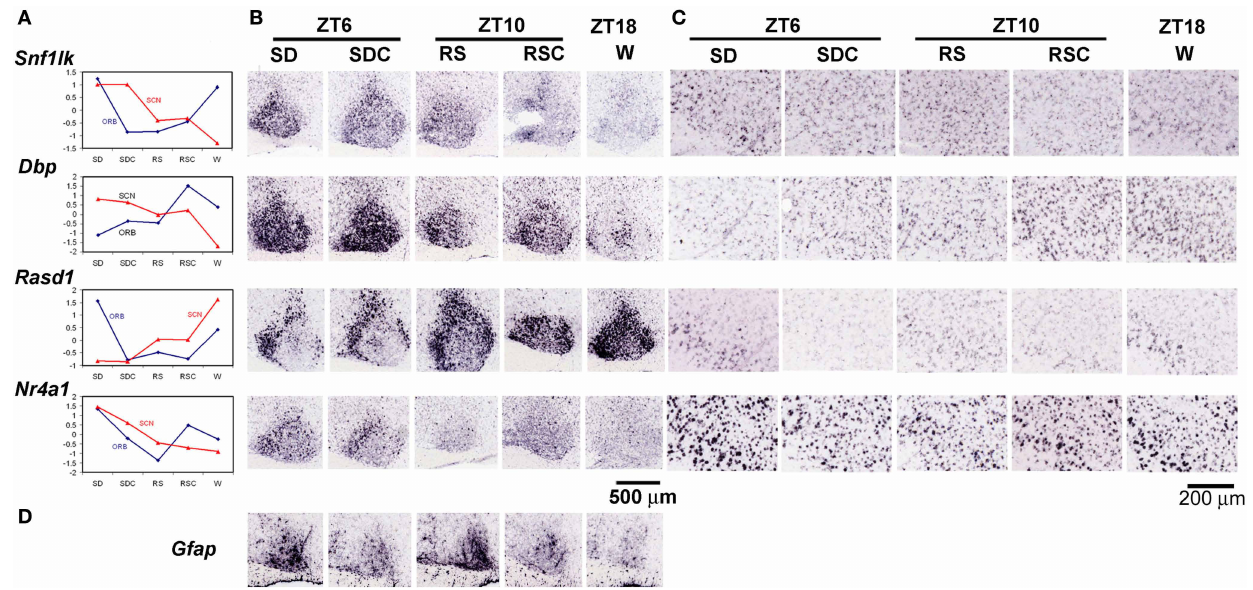
Figure 8 | Differential effects of behavioral condition on the SCN and orbital cortex. (A) Microarray values shown as z scores for four genes, Snf1lk , Dbp , Rasd1 , and Nr4a1 , for both orbital cortex (blue) and SCN (red), demonstrating the different trends shown for the same gene across different brain regions. (B,C) Colorimetric ISH on sagittal sections through the SCN (B)